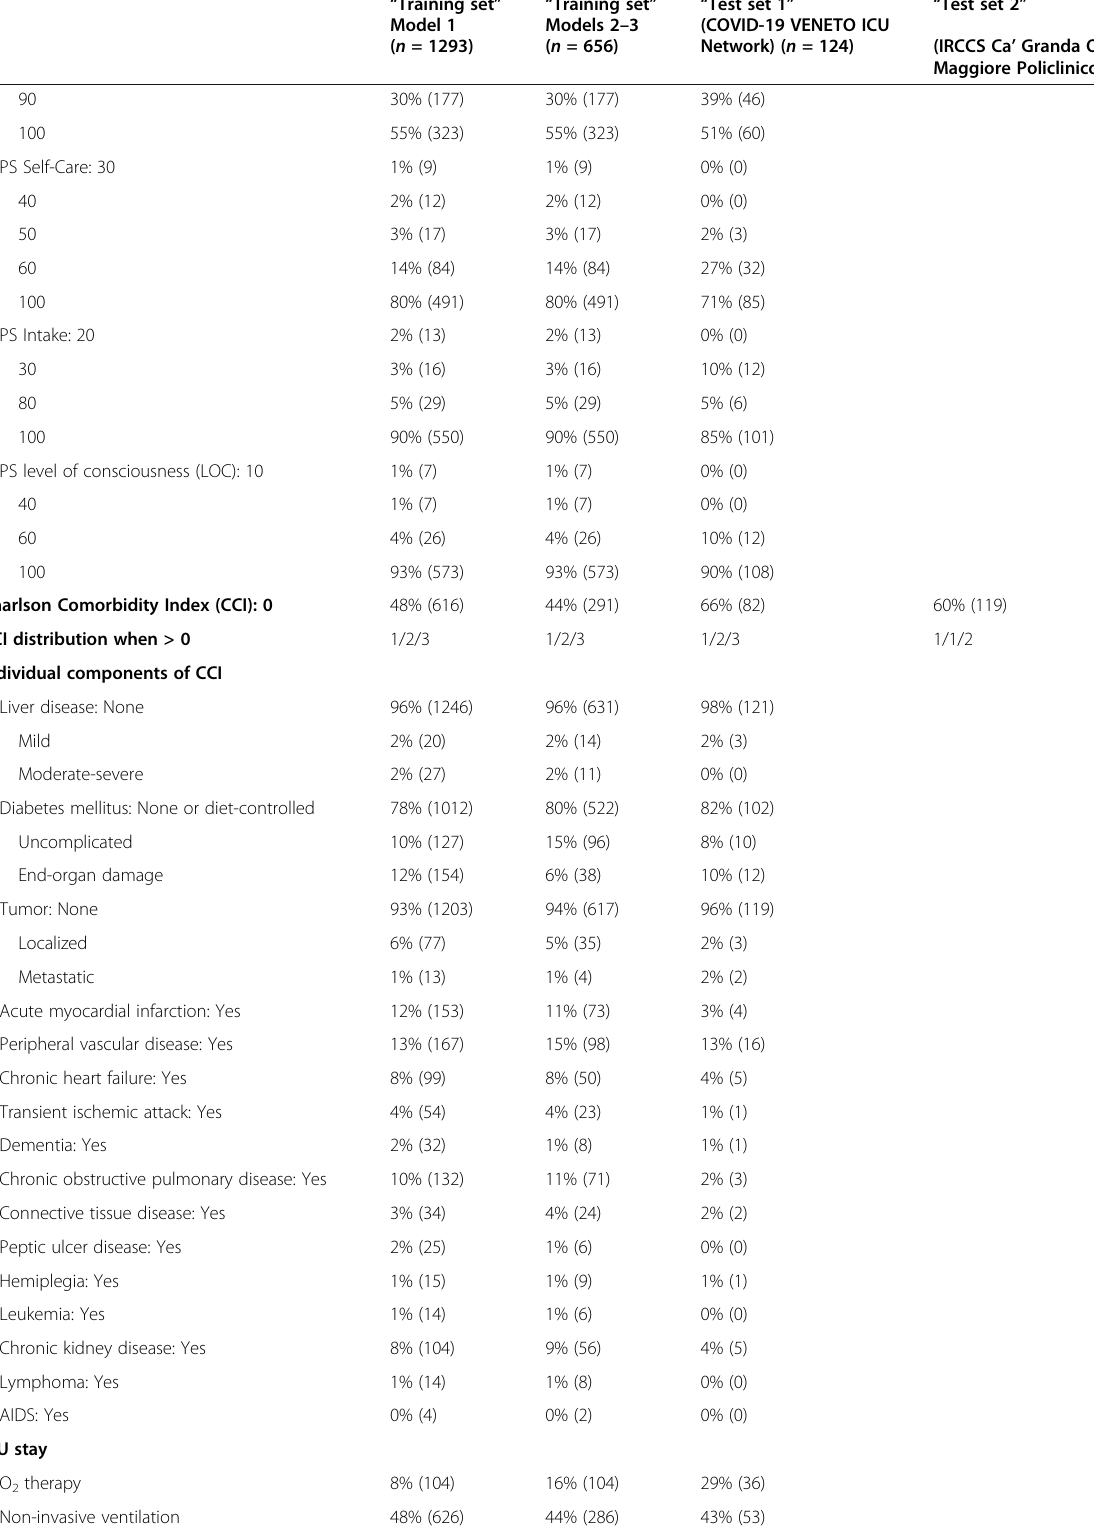
Table 1 Training and test sets characteristics